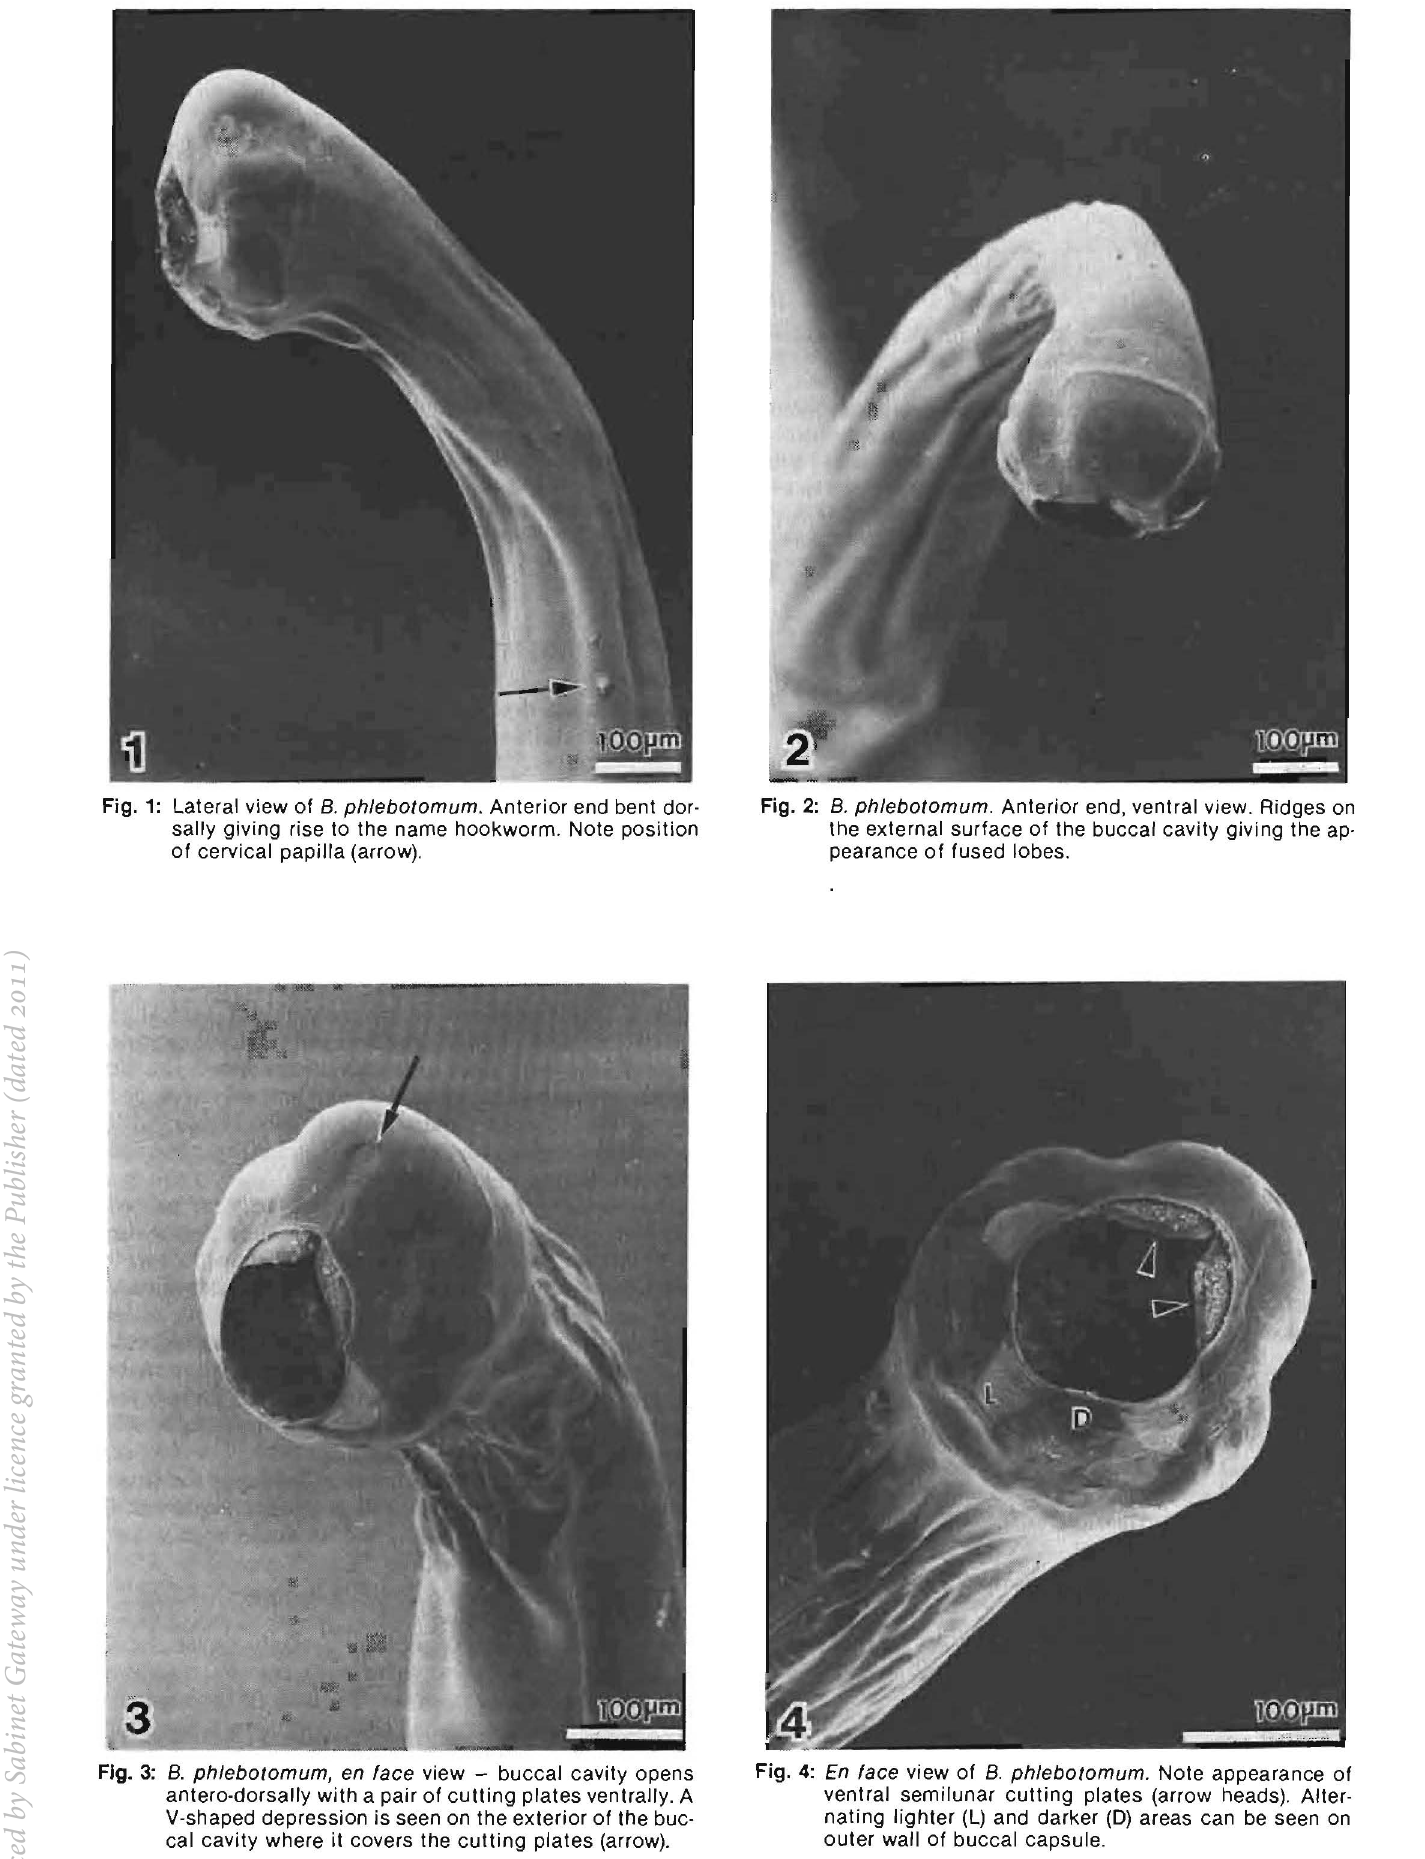
Fig. 4: En face view of B. phlebotomum. Note appearance of Fig. 3: B. phlebotomum, en face view - buccal cavity opens ventral semilunar cutting plates (arrow heads). Alter antero-dorsally with a pair of cutting plates ventrally. A nating lighter (L) and darker (D) areas can be seen on V-shaped depression is seen on the exterior of the buc outer wall of buccal capsule. cal cavity where it covers the cutting plates (arrow). TYDSKRIF VAN DIE SUID-AFRlKAANSE VETERINERE VERENIGING - DESEMBER